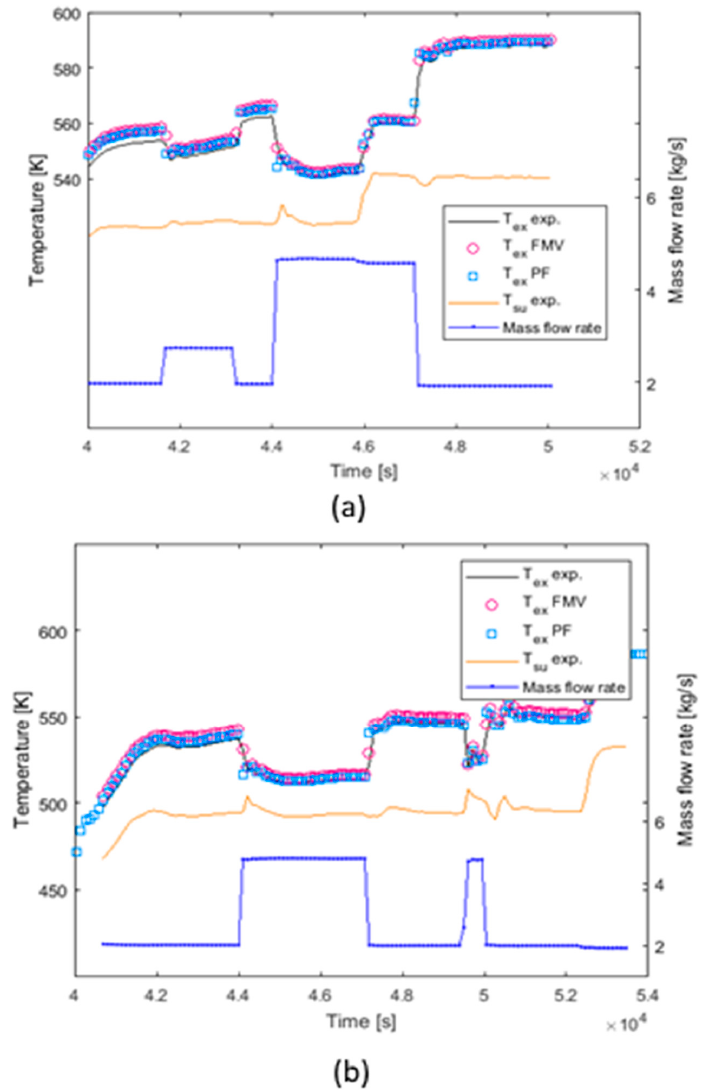
Figure 3. Experimental results performing different days versus plug flow and finite volume methods for several inlet temperature and mass flow rate conditions. ( a ) Test conditions #1; ( b ) Test conditions